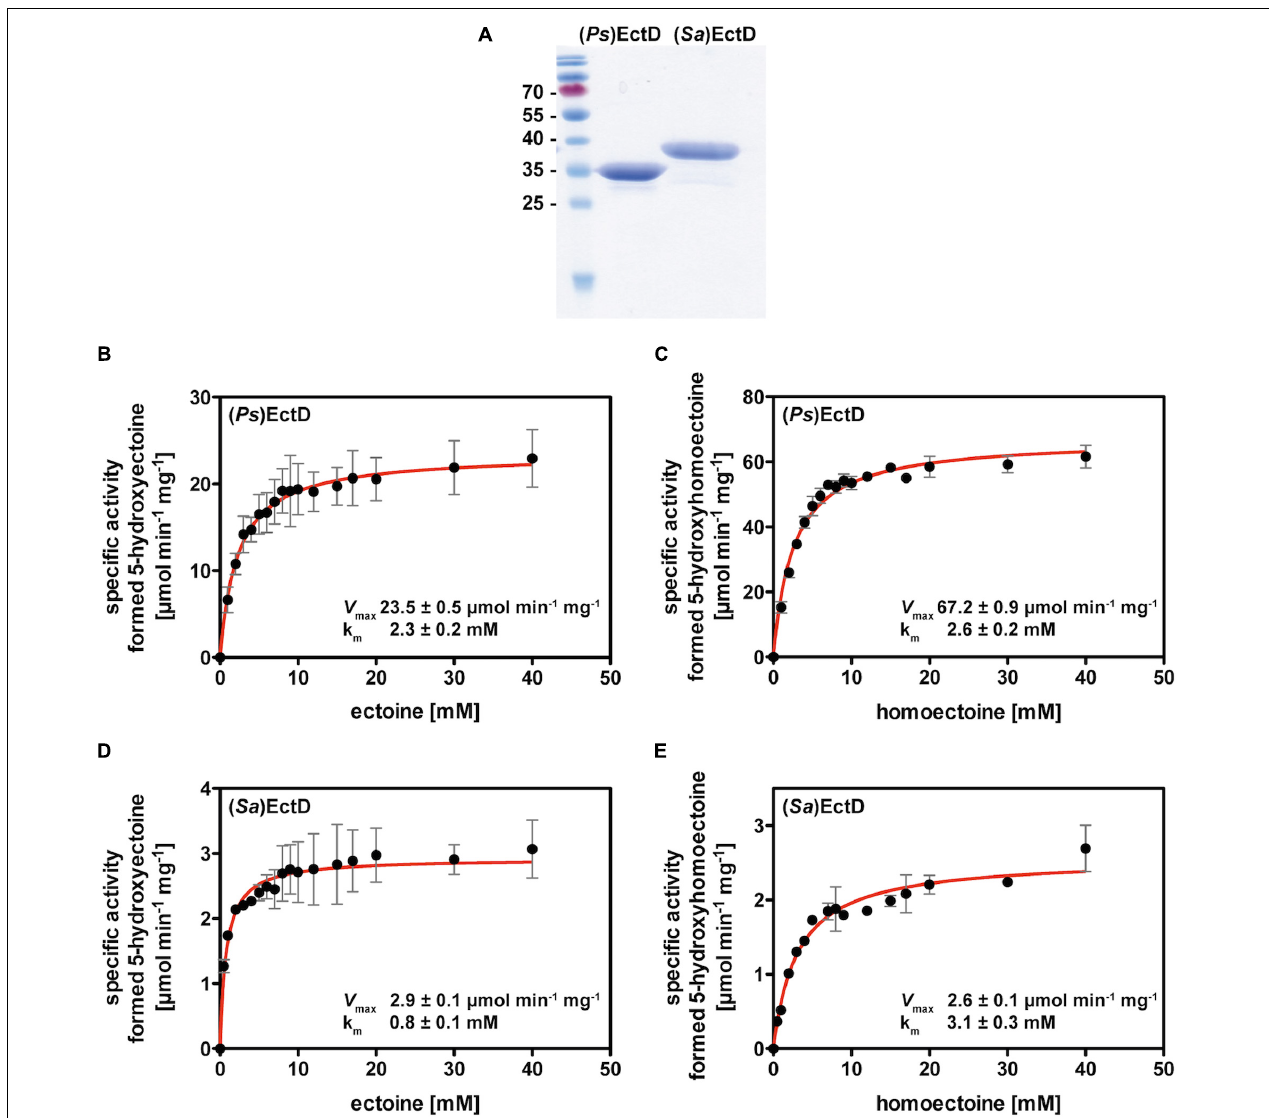
FIGURE 4 | Enzyme kinetics using recombinantly produced and affinity purified EctD proteins from P. stutzeri A1501 and S. alaskensis . (A) SDS gel of purified ectoine hydroxylases. Shown is a 15% polyacrylamide SDS gel with the purified recombinant ectoine hydroxylases from P. stutzeri A1501 [ ( Ps )EctD ] and S. alaskensis [ ( Sa )EctD ] . The proteins were overexpressed in E. coli and purified via Strep-Tag -II affinity chromatography. 3 µ g of both enzymes were applied to the gel and the pre-stained PageRuler Protein Ladder (Thermo Scientific) was used as a marker to size the migration of the two EctD proteins. (B,C) Kinetic